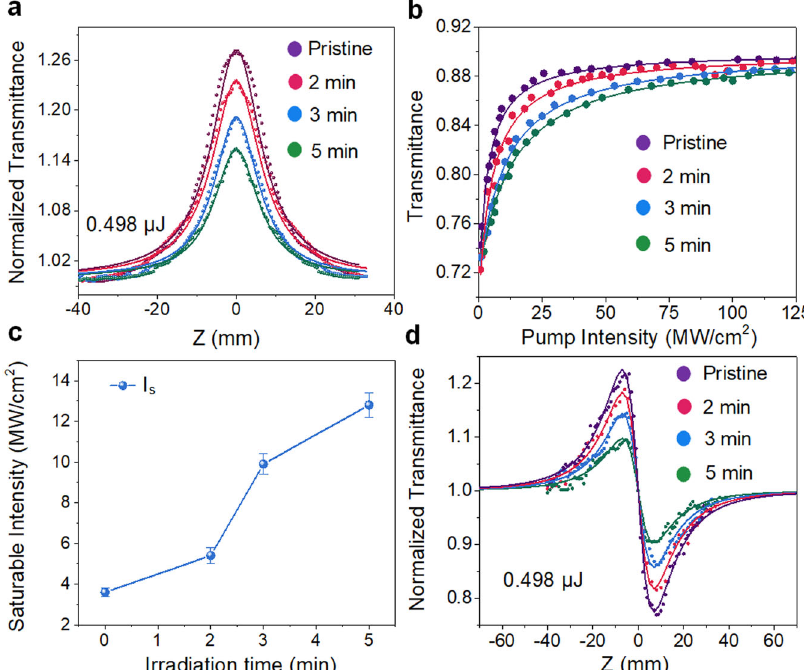
Fig. 3 Defect-mediated nonlinear absorption properties. a Open-aperture Z-scan results of the Bi 2 O 2 Se nanoplates under different plasma irradiation times with an input pulse energy of 0.498 µ J. It can be well fi tted by Supplementary Equation (1) (solid lines). b Nonlinear transmittance of Bi 2 O 2 Se nanoplates under different plasma irradiation times. The solid lines show that the fi tting results by Eq. (3) are well-matched with the experimental results. c Trend of the saturation intensity of Bi 2 O 2 Se nanoplates under different plasma irradiation times. The error bars are the fi tting error, which are obtained from the fi tting results by Eq. (3). d Closed-aperture Z-scan results of the Bi 2 O 2 Se nanoplates under different plasma irradiation times with an input pulse energy of 0.498 µ J. It can be well fi tted by Supplementary Equation (4) (solid lines). Table 2 Comparison of β eff and n 2 values between Bi 2 O 2 Se nanoplates and other nanomaterials.